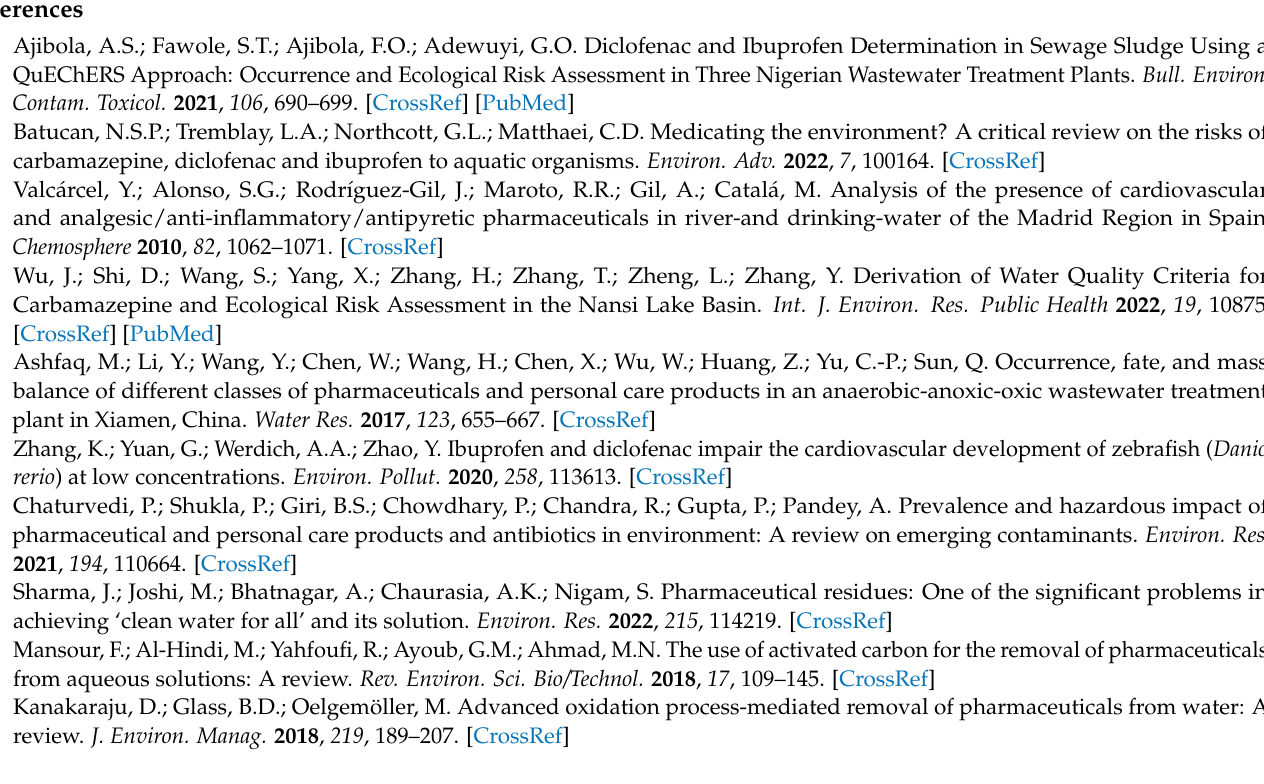
Figure S2: The calibration curves of three pharmaceuticals, the regression coefficients were R2 > 0.99. Figure S3: The pH values of the six reactors (Y represented the anaerobic zone while H represented the aerobic zone). Figure S4: The DO concentrations of the six reactors (Y represented the anaerobic zone while H represented the aerobic zone). Figure S5: The total COD efficiencies of Rac, Rca, and Rop. Table S1: The Coverage values of